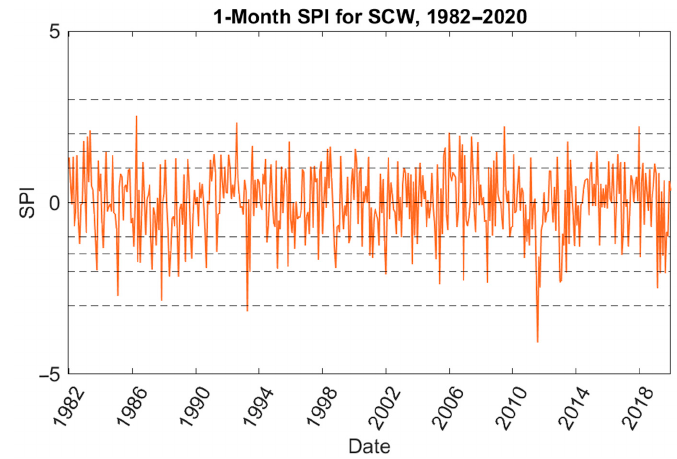
Figure A5. 1 ‐ Month SPI from 1982 to 2020. Figure A5. 1-Month SPI from 1982 to 2020.